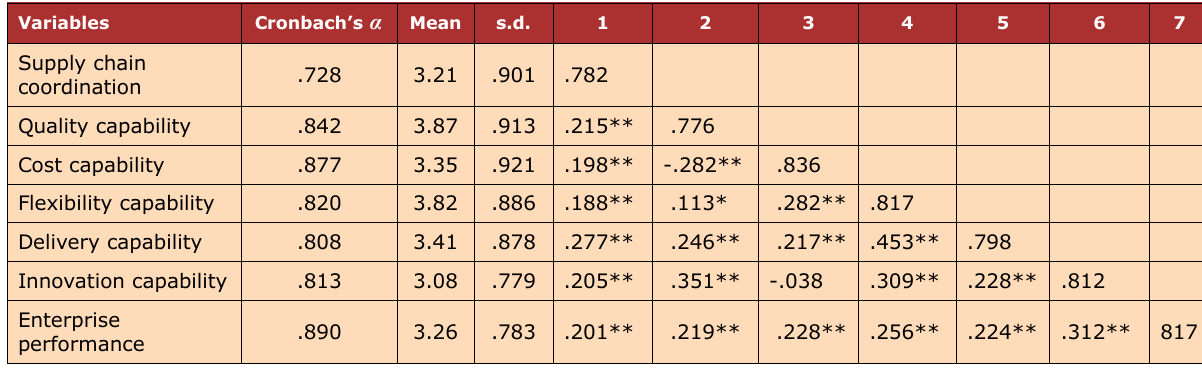
Table 4. Reliability, validity and correlation